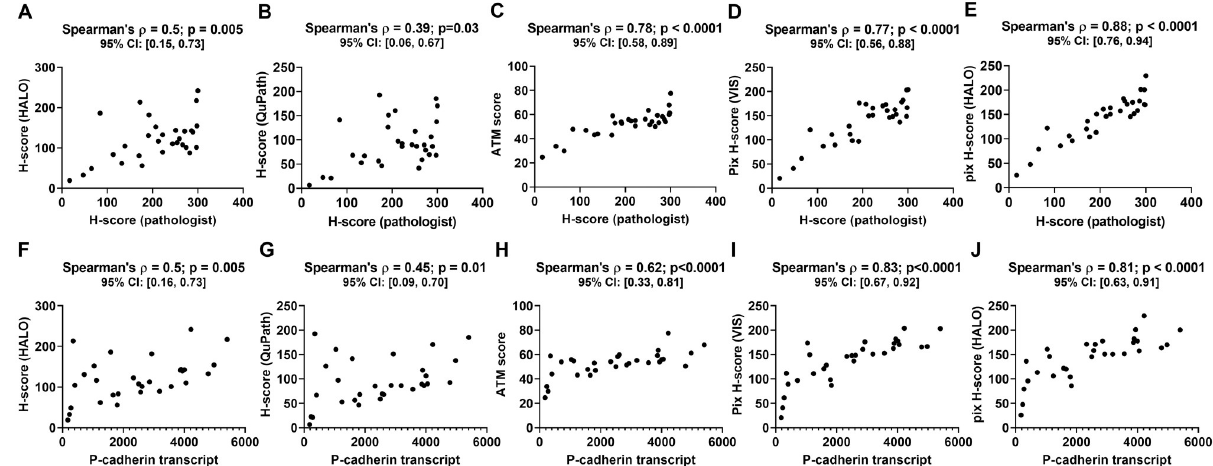
Fig 3. Performance of DIA endpoints obtained from P-cadherin IHC images. Panels A through E show the plots of different DIA endpoints versus pathologist H-score for a cohort of 30 head and neck cancer resections. Panels F through J show the plots of different DIA endpoints versus P-cadherin mRNA transcript for the same 30 cases. Each panel also shows the Spearman’s correlation coefficient between the two quantities plotted in that panel along with the p-value and the 95% confidence